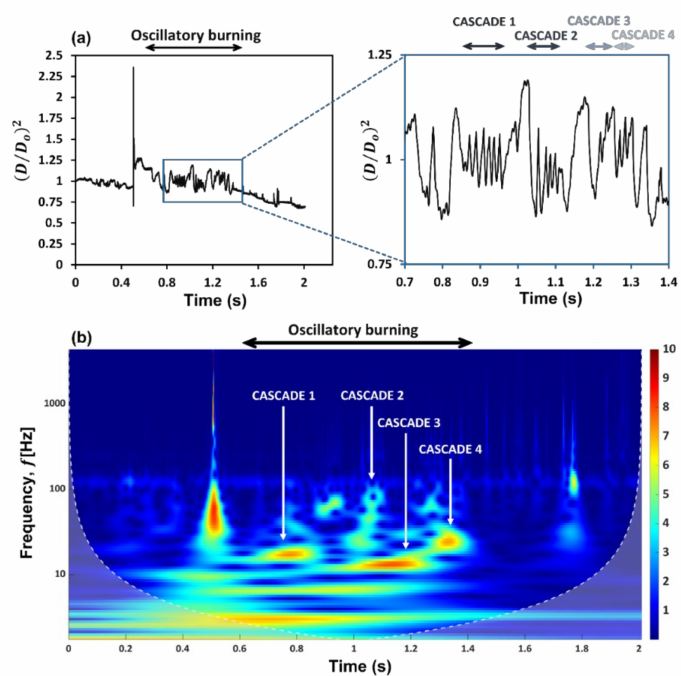
Figure 1. ( a ) Diameter time history of ethanol-based HPMC-3% gel fuel droplet. ( b ) Contin- uous wavelet spectra (CWT) or scalogram of the diameter time signal showing frequencies for Gels 2023 , 9 , x FOR PEER REVIEW diametrical fluctuations.